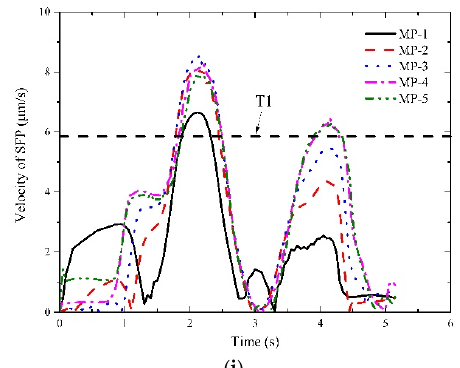
Figure 7. Responses of the indicators of interest at 300 km/h. (a) responses of I1 under a seal index of